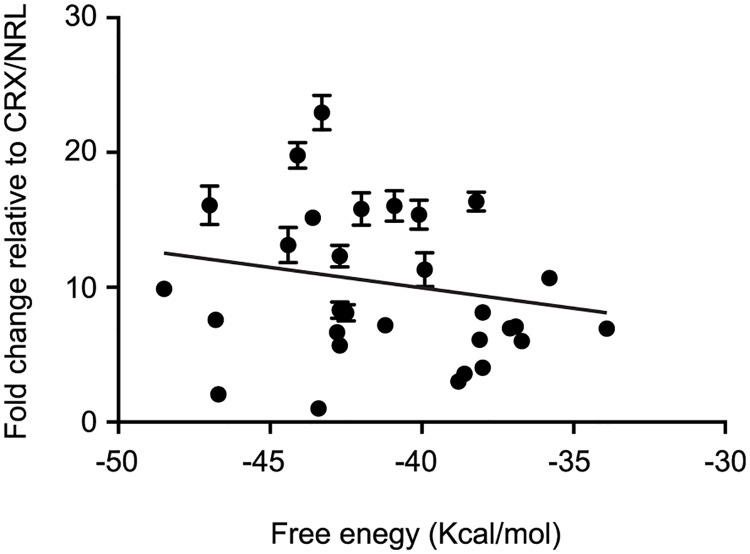
shRNA-mediated rho-Gluc activity and thermodynamic stability.The minimum free energy of shRNAs and their effect on rho-Gluc activity were plotted. Error bars are shown as SE.